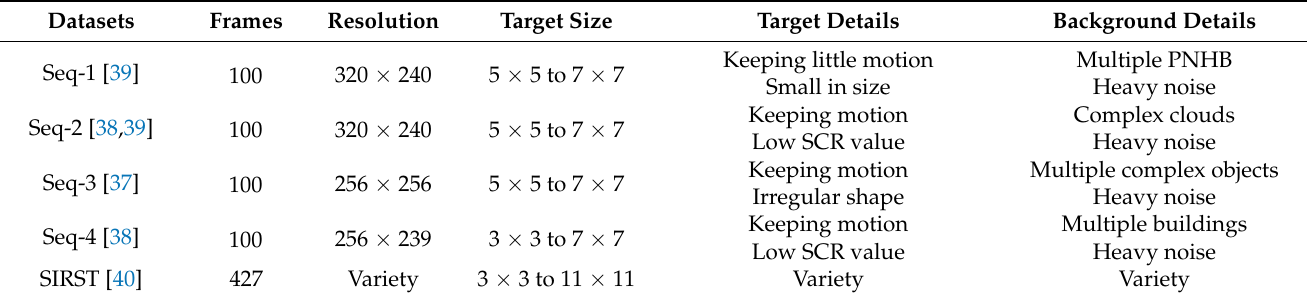
Table 1. Information of the test